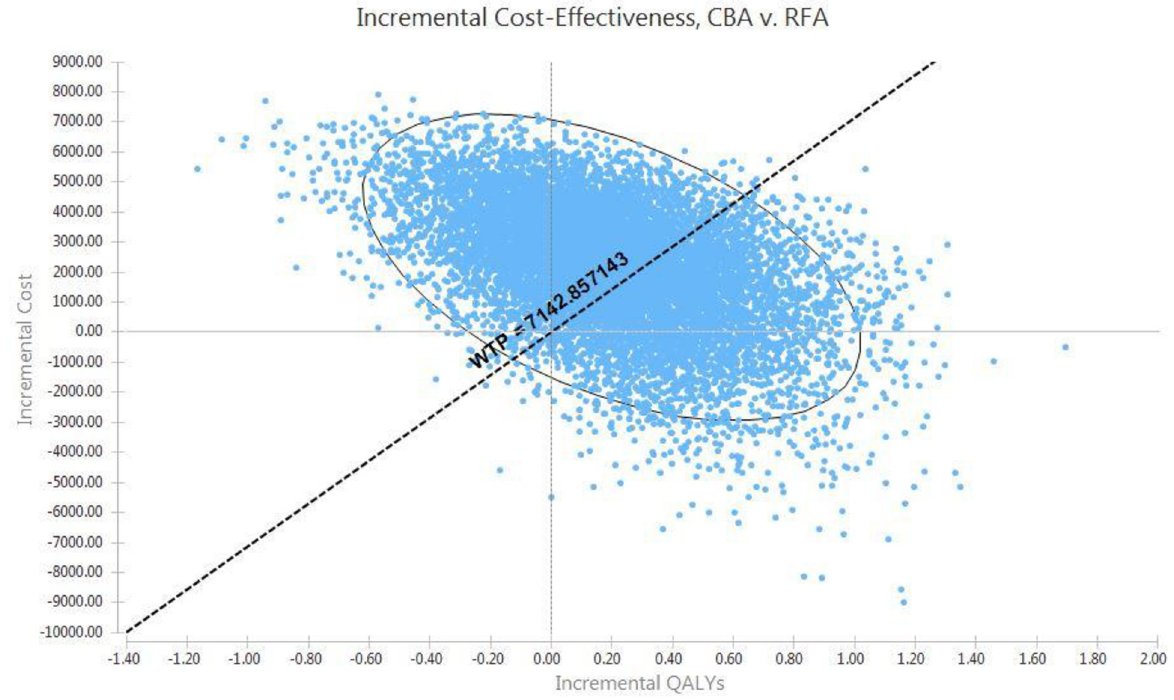
Fig 6. Incremental cost-effectiveness scatter plot for